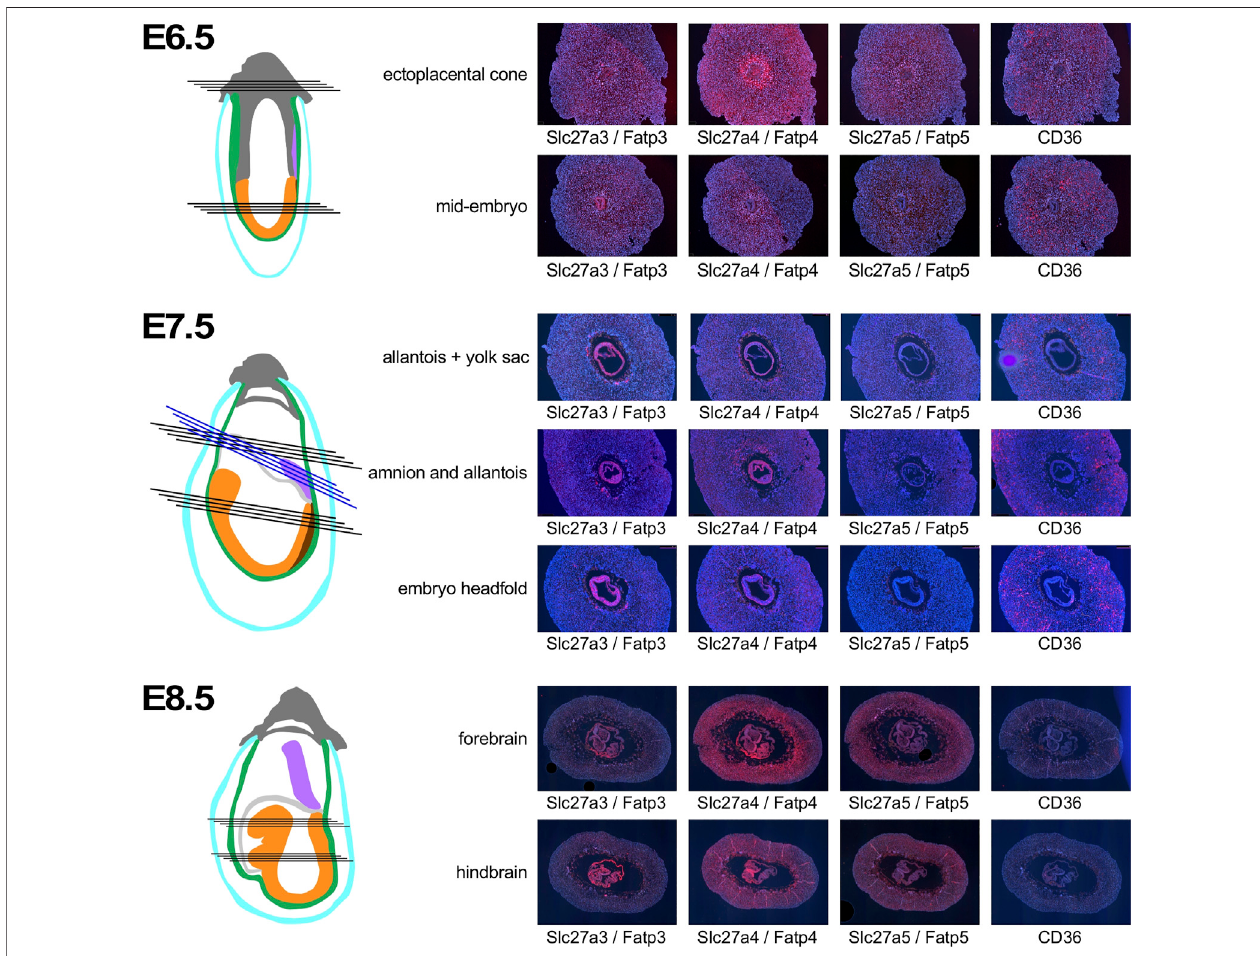
FIGURE 5 | Expression of Fatty acid transporter genes in early pregnancy. Decidua from pregnant females of the NOD mouse strain were isolated at various time pointsofpregnancy,andserialsectionswereproduced.AdjacentsectionsfromdifferentanatomicallocationswerehybridizedwithRNAscopeprobesfortherespective nutrient transporters. Schematic representations indicate the orientation of sections through tissues of the implantation sites: dark grey: extraembryonic cells and ectoplacentalcone;turqoise:parientalyolksac;green:visceralyolksac,purple:allantois;lightgrey:amnion;orange:embryoproper;brown:primitivestreak.Black lines indicate sections produced from the same implantation site, blue lines indicate sections from a different sample for amnion and allantois at E7.5. Where possible, embryo sections are oriented with anterior (head) to the left.